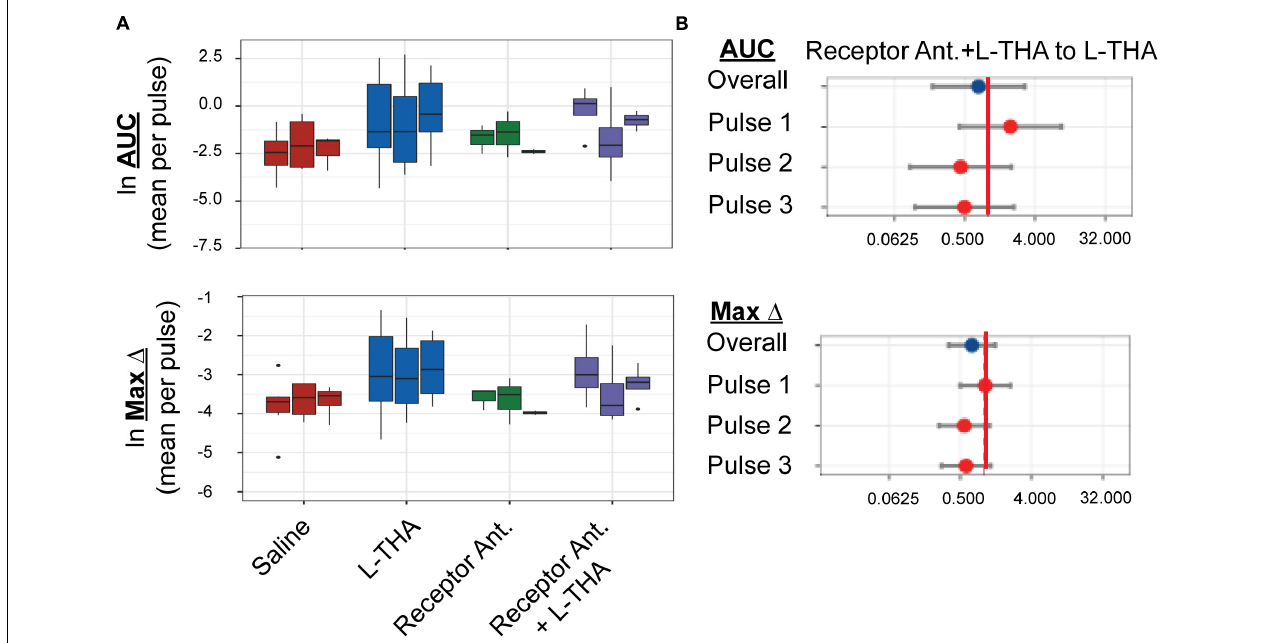
FIGURE 5 | Effects of saline, L-THA, receptor antagonists, and receptor antagonists with L-THA on arteriole diameter. Saline, L-THA (100 µ M), receptor antagonist cocktail [DNQX (10 µ M)/D-APV (50 µ M)/MCPG (1 mM)/R-Baclofen (100 µ M)], or a combination of receptor antagonist cocktail with L-THA were picospritzed near cortical arterioles. (A) Data are presented as boxplots. (B) Forest plots are also included to show the mean differences expressed as ratios of the effect of Receptor Antagonists with L-THA over that observed with L-THA. The redline is at 1 and represents no difference. The data for saline and L-THA are described in Figure 4 legend, the data for receptor antagonists are from 3 animals (1 male, 2 females) and the data for receptor antagonists with L-THA are from 4 animals (1 male, 3 females).